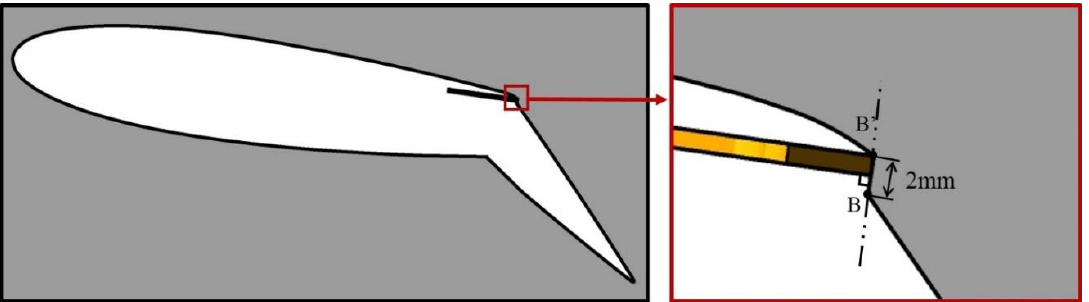
Figure 3. Installation location of fluidic oscillators.